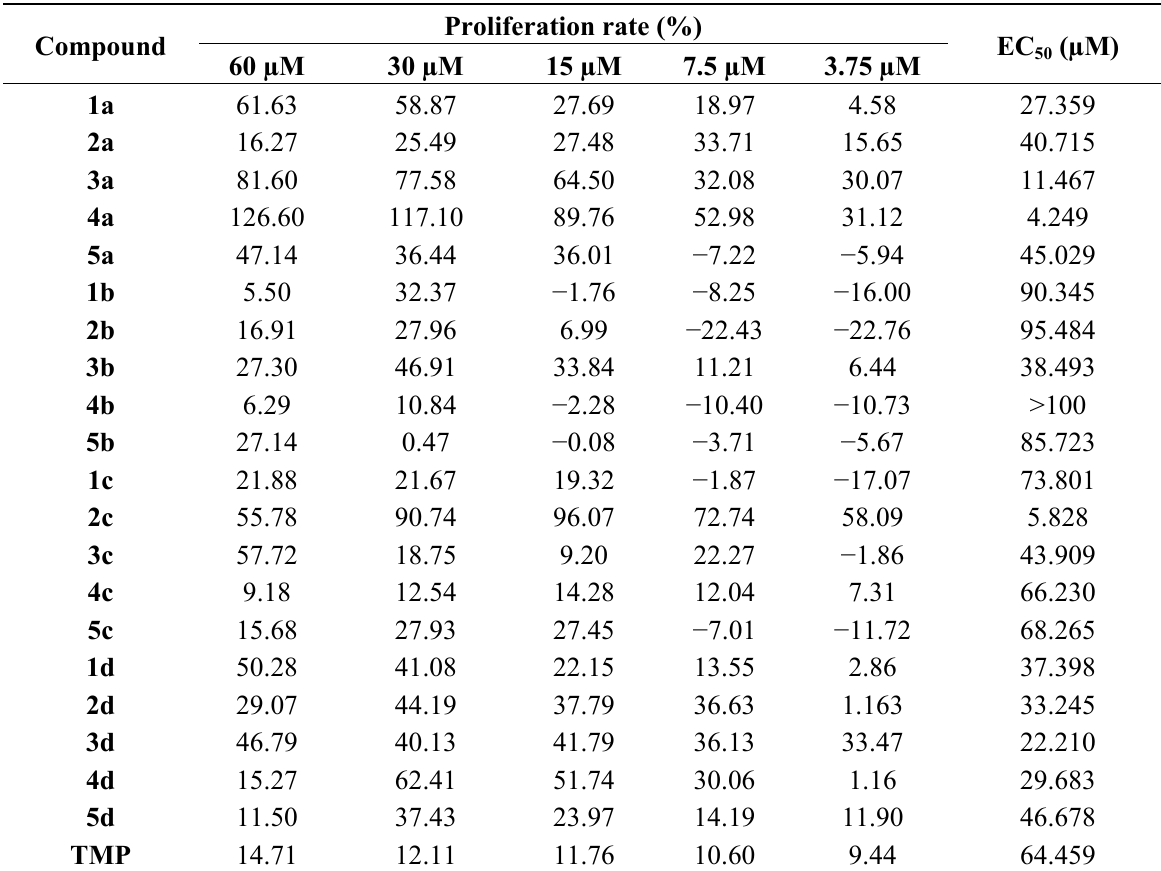
Table 2. The EC of the ligustrazine-benzoic acid derivatives for protecting damaged 50 PC12